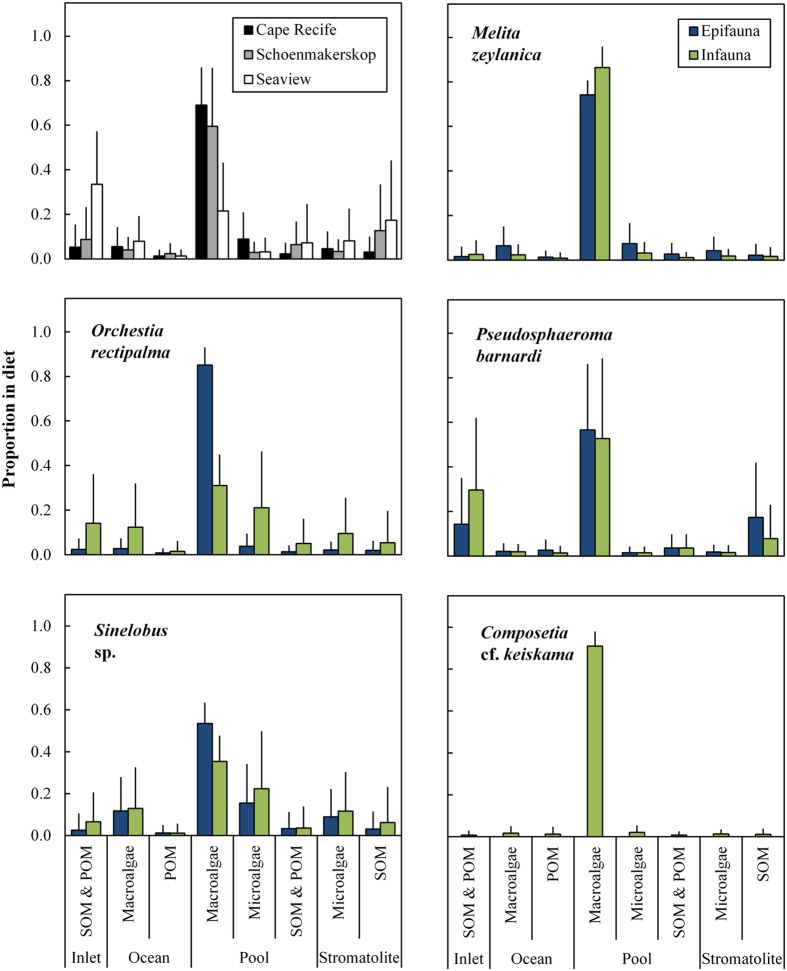
Relative proportion of organic matter sources (±SD) in the diets of dominant primary macrofaunal consumers, collected from stromatolite pools during August 2015.Diets were assessed using δ13C and δ15N isotopes as biotracers within a Bayesian mixing model, fitted using MixSIAR62. Proportions are expressed according to sampling sites and species, which were nested as hierarchical random factors within the mixing model. Species are reflected as infauna (green) and epifauna (blue) depending on their association with the stromatolite matrix. SOM (sediment organic matter); POM (particulate organic matter).